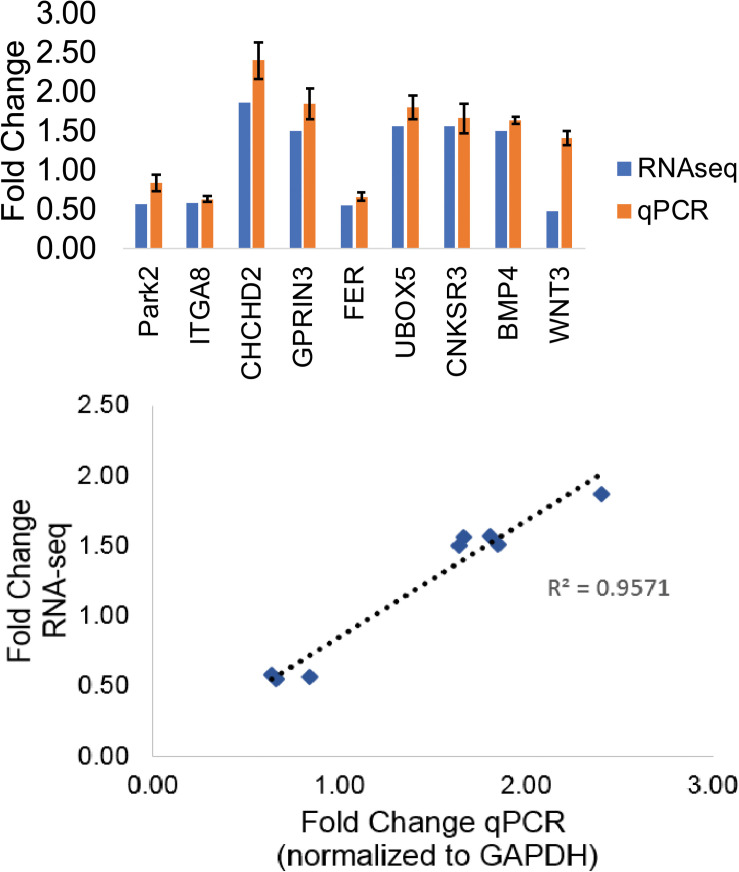
RNA-sequencing validation of PD-associated genes. Fold-change comparison of RNA sequencing results versus qPCR results and the linear calibration curve of RNA sequencing results with qPCR results expressed as fold change in expression.